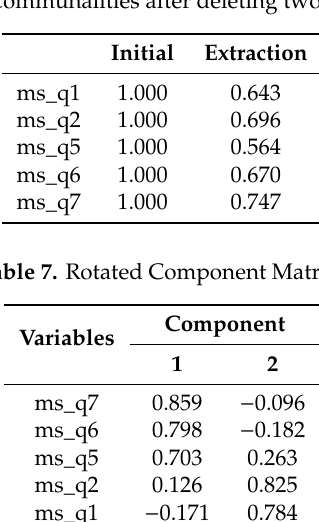
Table 6. Communalities after deleting two variables.